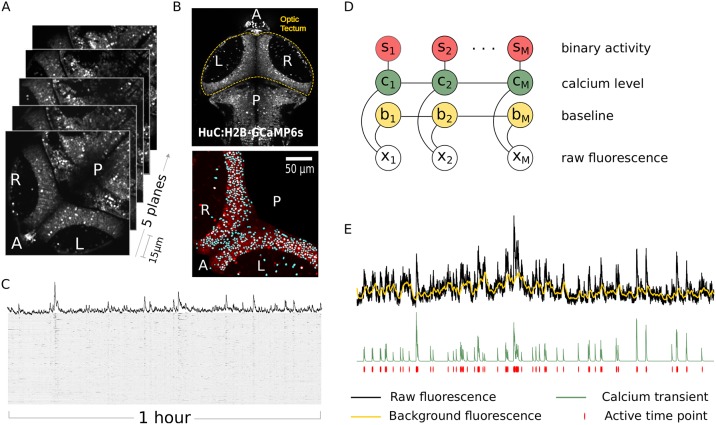
Imaging of the zebrafish tectum.(A) Volumetric 2-photon imaging of both tectal hemispheres showing anterior/posterior (A/P) and right/left (R/L) axis of the zebrafish optic tectum. We monitored activity in the tectum of immobilized zebrafish larvae kept in total darkness. In all experiments we recorded calcium activity for 1 hour throughout 5 planes, 15μm apart with an acquisition frequency of 4.8Hz per volume. (B) Raw images (top) were segmented (bottom) to obtain the temporal dynamics of calcium of thousands of neuron in the tectum (see also S1 Video). (C) Raster plot showing calcium activity of all neurons over 1h recording. (D) Raw fluorescence is described in terms of a Hidden Markov model (HMM) where periods of increased activity are indicated by a binary process ({s}) triggering the onset of calcium transients ({c}). The recorded fluorescence is obtained as the sum of calcium level and a Wiener process to account for the low-frequency baseline modulation ({s}) (see Materials and methods). (E) Example of raw fluorescence and estimation of hidden variables of the HMM using a sequential maximum-likelihood algorithm (see Materials and methods).